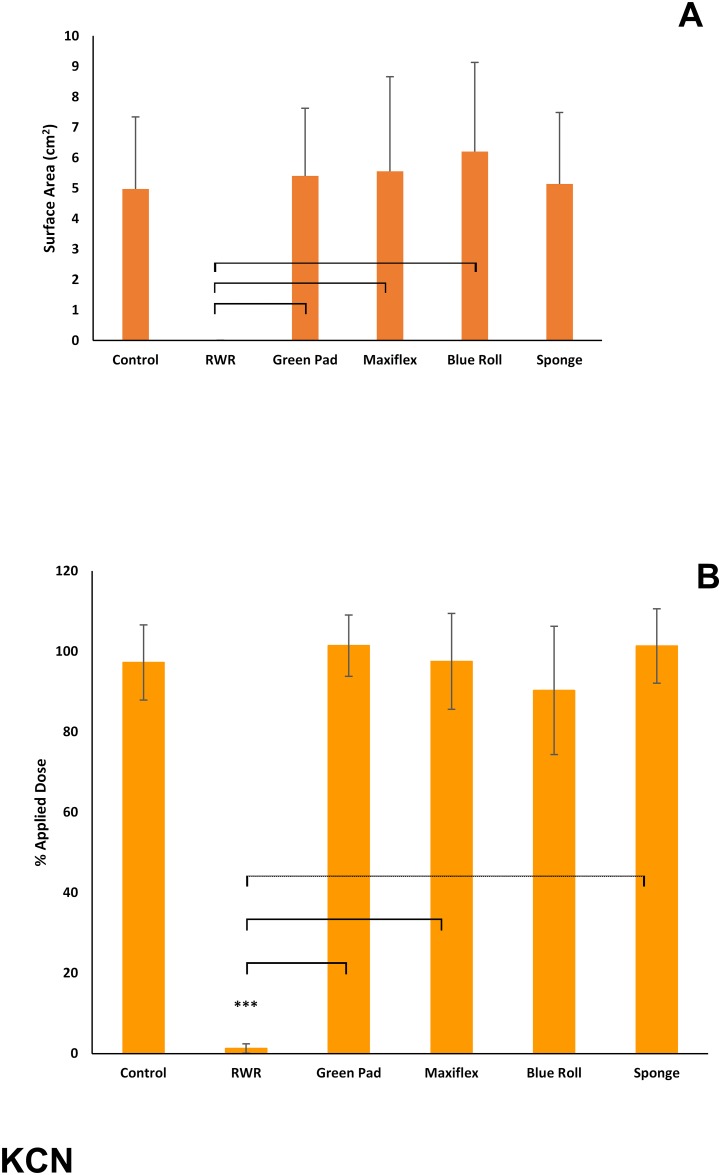
(A) Skin surface spreading and (B) recovery of 14C-potassium cyanide (expressed as percentage of applied dose) remaining on, within or penetrated through dermatomed pig skin following decontamination (after 15 minutes) with test products (green incontinence pads, Maxiflex wound dressing, absorbent tissue paper (blue roll) or polyurethane sponge) or the rinse-wipe-rinse method (RWR).All values are mean ± standard deviation of n = 6 replicates. Asterisks indicate significant differences between treated and untreated (control) skin: *p<0.05; **p<0.01; ***p<0.001. Horizontal brackets indicate significant differences (p<0.05) between treatment groups.